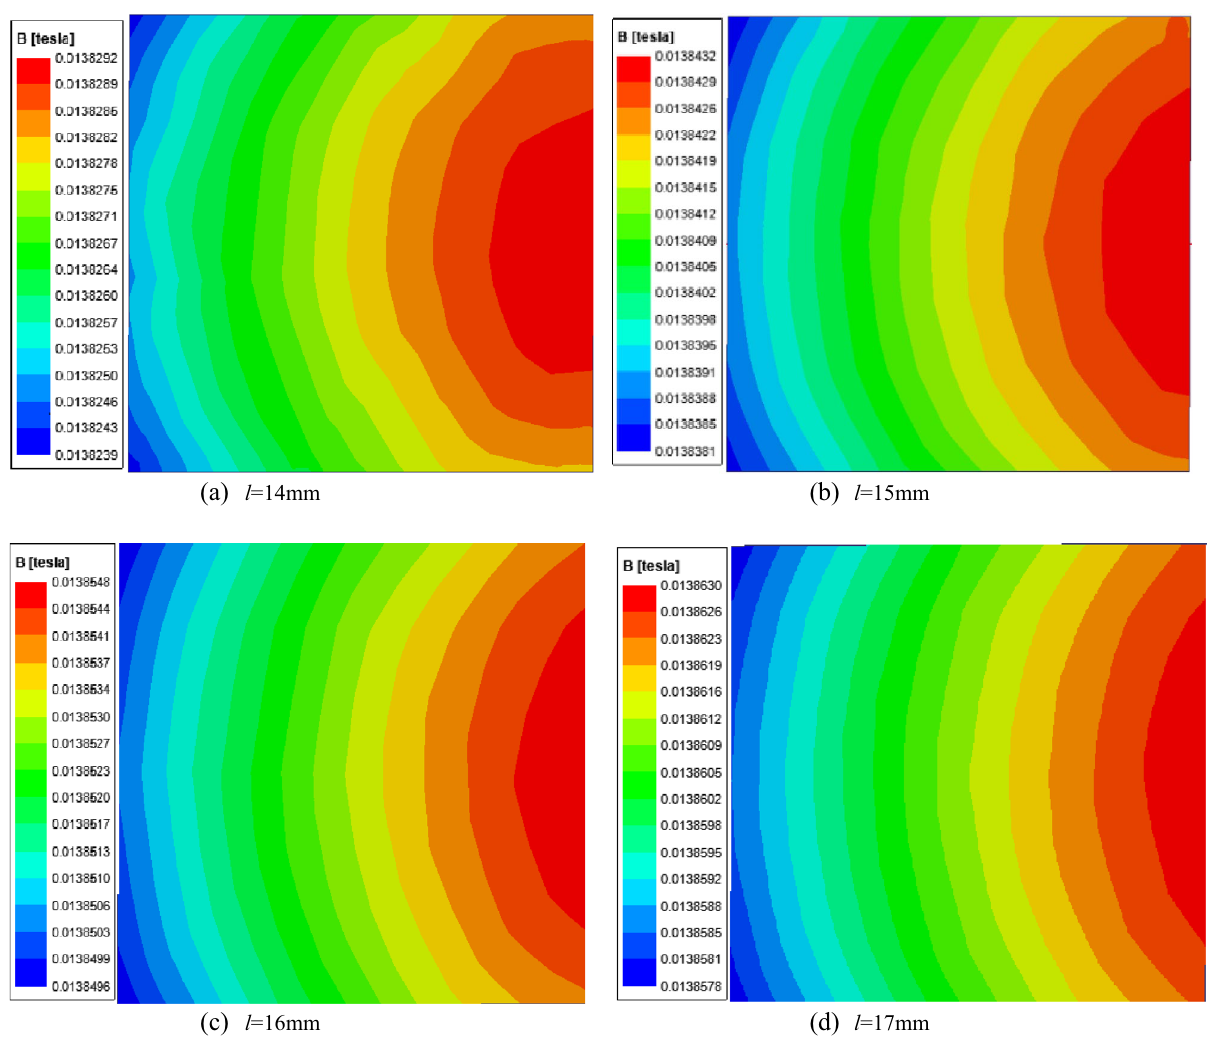
Figure 7. Magnetic field of different l when δ = 2.2